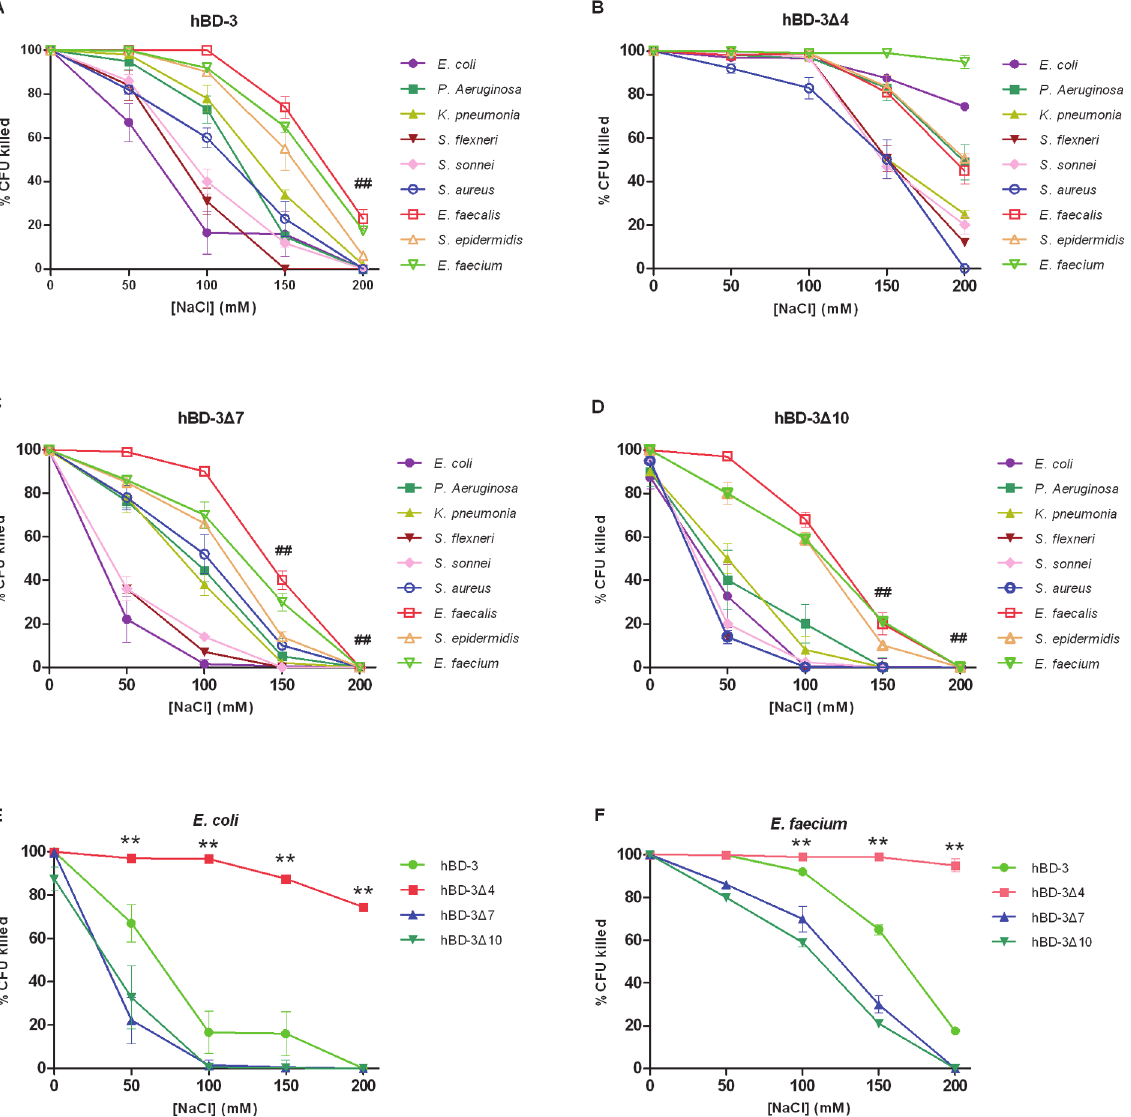
Fig 1. Antibacterial activity at increasing NaCl concentrations of hBD-3 (A), hBD-3 Δ 4 (B), hBD-3 Δ 7 (C) and hBD-3 Δ 10 (D) against nine bacterial strains or species; and of hBD-3 and analogs against E. coli ATCC 25922 (E) and E. faecium ATCC 6057 (F). Error bars show the SDs of experiments performed in triplicate. Non parametric tests were used in the statistical analysis. ** Significantly different ( P < 0.01) from the activity of wild-type hBD-3. ## Significantly different ( P < 0.01) from the activity of hBD-3 at 0 mM NaCl.